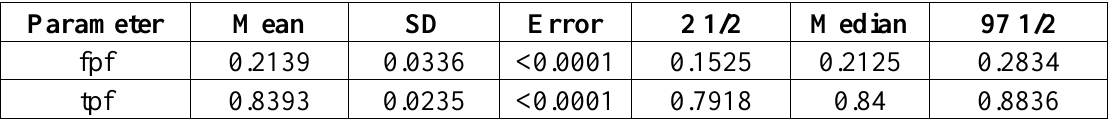
Table 14. Posterior distribution for hepatic scintigraphy study.